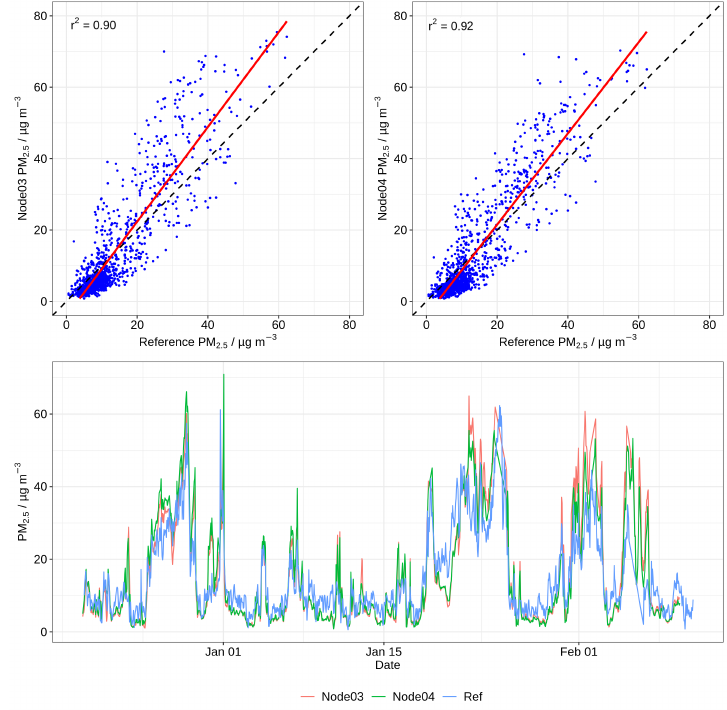
Figure A1. Correlation plots ( top ) for Node03 ( right ) and Node04 ( left ) versus reference measurements for the raw sensor output of PM 2.5 . A linear regression fit line (solid red line) and a 1:1 line (dashed black line) are shown in both panels. Time series (bottom) of two sensor nodes (Node03 and Node04) and reference air quality monitoring station. All data shown are 1 h average